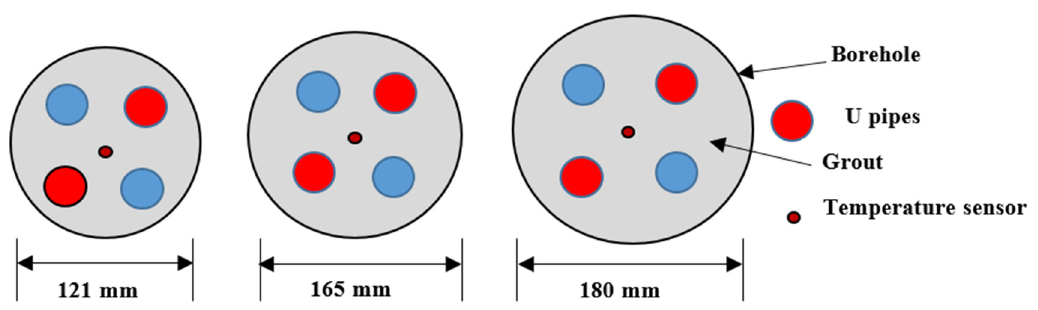
ff erent borehole Figure 14. Cross section of different borehole diameters. Figure 14. Cross section of di Figure 14. Cross section of different borehole diameters.